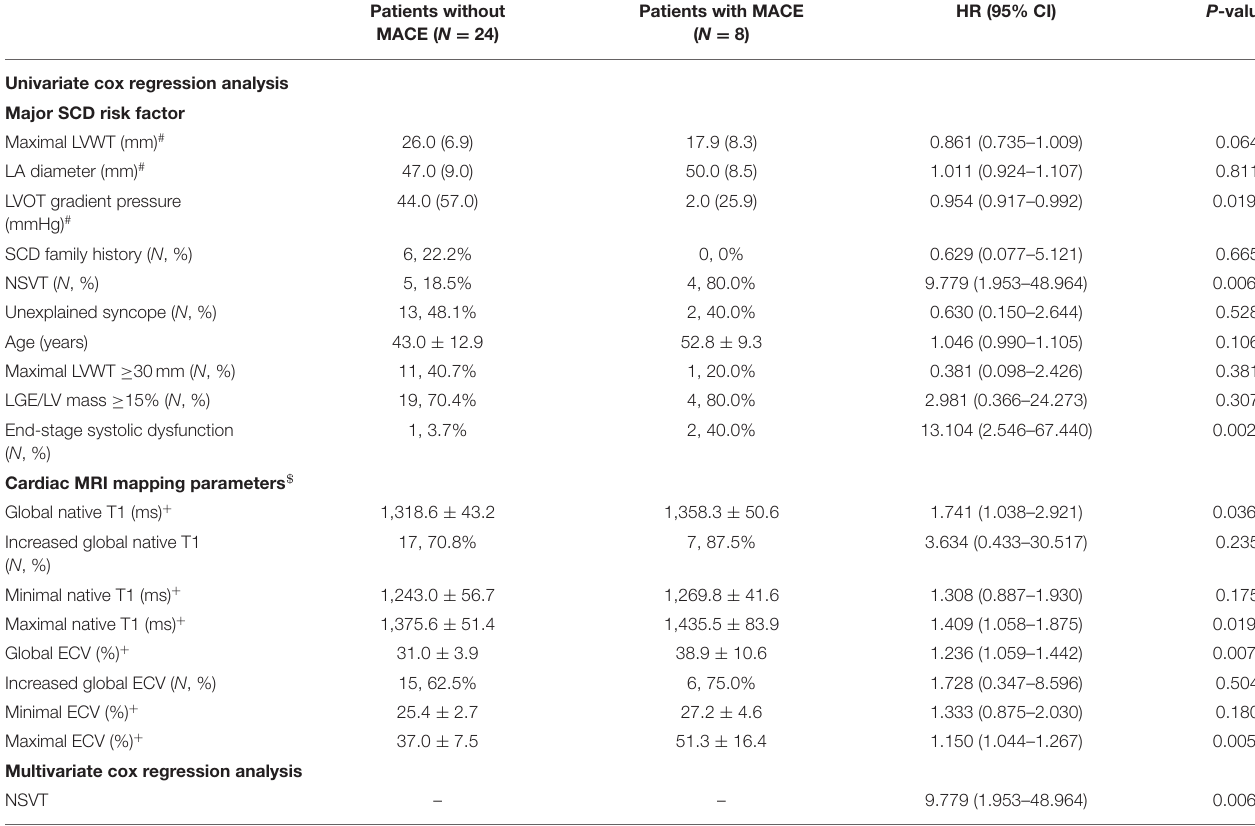
TABLE 8 | Univariate and multivariate cox regression analysis of T1 mapping values for the prediction of MACE in subgroup 3.